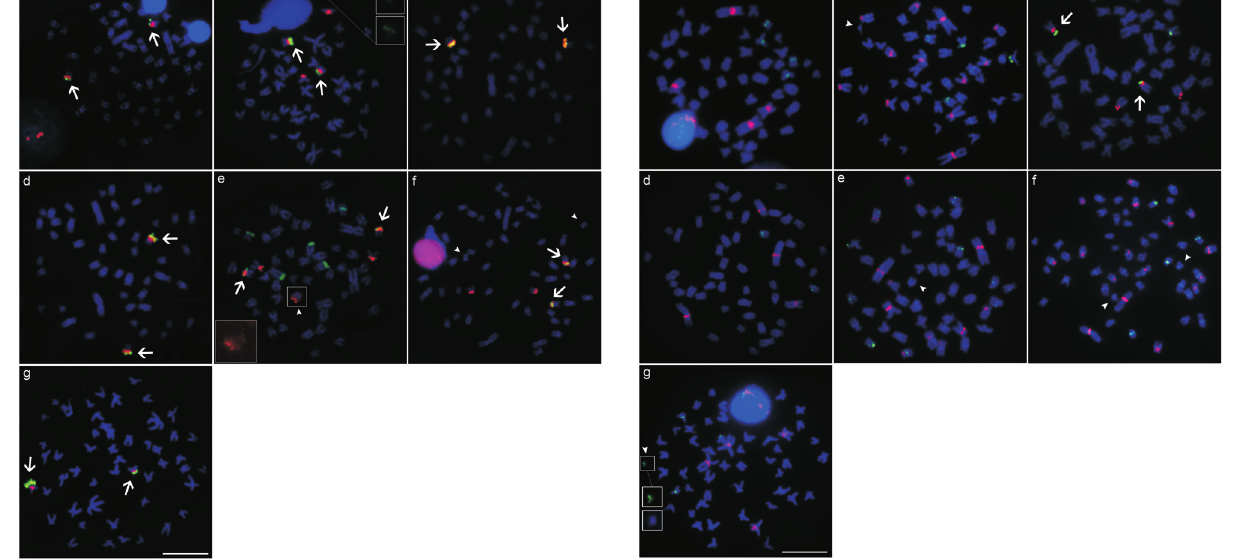
Figure 5 - Metaphases mapped by double-FISH with H1 histone (red) and 18S rDNA (green) probes in: (a) M . cosmops ; (b) M . forestii ; (c) M . nigromarginata ; (d) Moenkhausia sp. n.; (e) M . oligolepis (Xapuri River); (f) M . oligolepis (Corredeira Stream), and (g) M . oligolepis (Sangue River). Chromosome synteny between markers is indicated by the arrows, while the B chromosomes are shown by the arrowheads. Scale bar = 10 (cid:2) m.